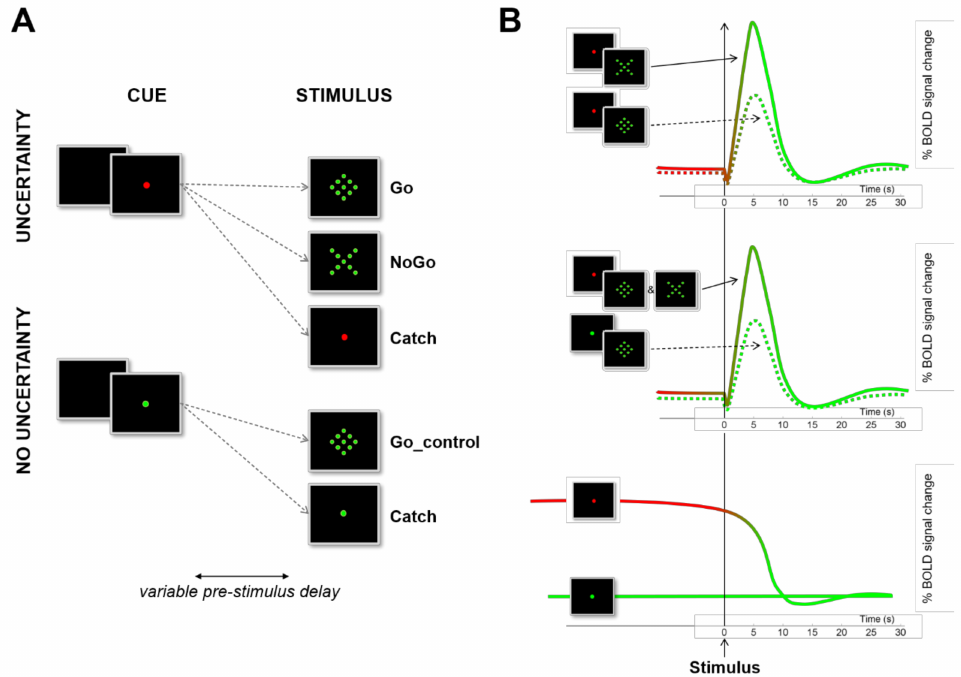
Figure 2. Design and rationale. ( A ) Illustration of the design used to assess three different forms of inhibitory control with a simple Go/NoGo task. Participants were asked to react as fast as possible to a Go stimulus (diamond) by means of a button press, or to withhold the prepotent response to an equiprobable NoGo stimulus (X). ( B ) Illustration of the contrasts used to identify the different possible forms of response inhibition on the basis of their respective BOLD dynamical signature. The reader is referred to [21] for more details about the methods and to [36] for a critical review and a meta-analysis of the standard contrasts used to evidence reactive inhibition in Go/NoGo